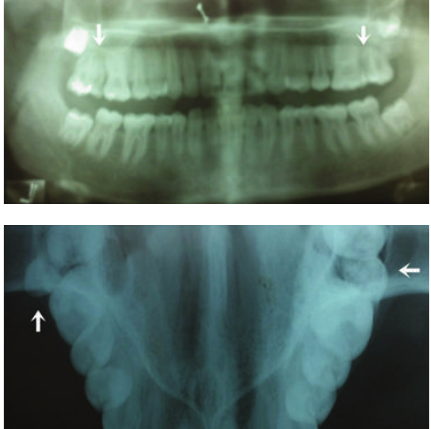
Figure 5: Showing bilateral paramolars in occlusal and panoramic views in case-2.